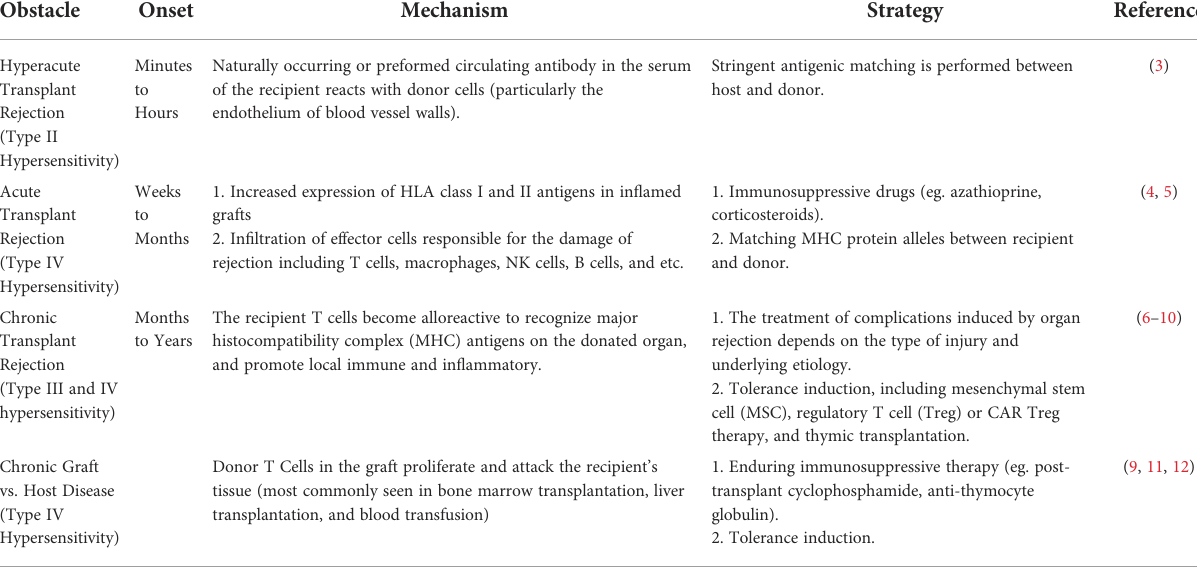
TABLE 1 Obstacles and relevant strategies in human